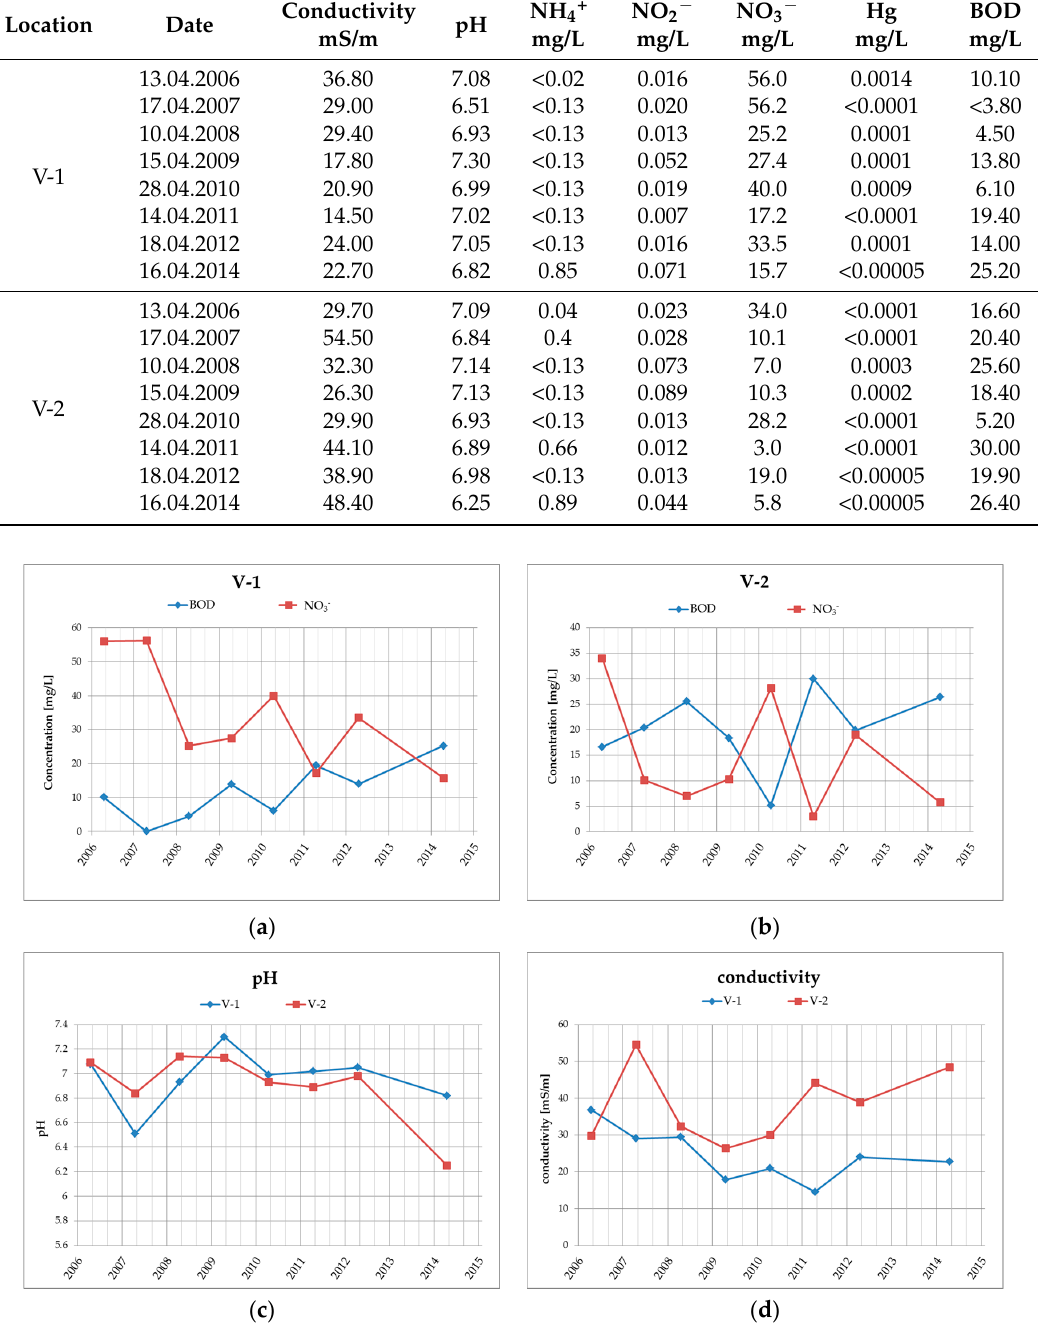
Figure 4. Graphical illustration of the long-term trend of ( a ) BOD and NO 3 − in borehole V-1; ( b ) BOD and NO 3 − in borehole V-2; ( c ) water reaction—pH in boreholes V-1 and V-2; ( d ) conductivity in boreholes V-1 and V-2.